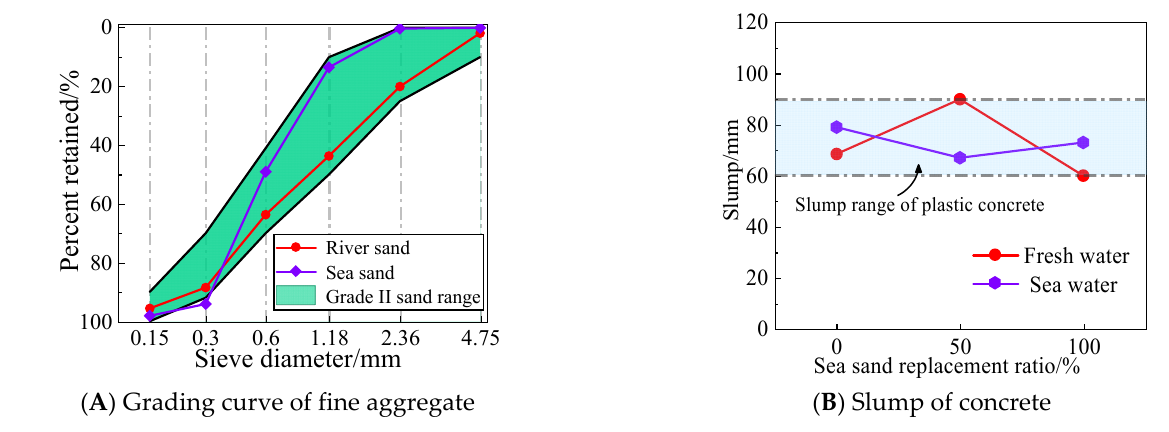
Figure 3. Fine Aggregate Grading Curve and Concrete Slump. Table 2. Mix proportions of concrete.